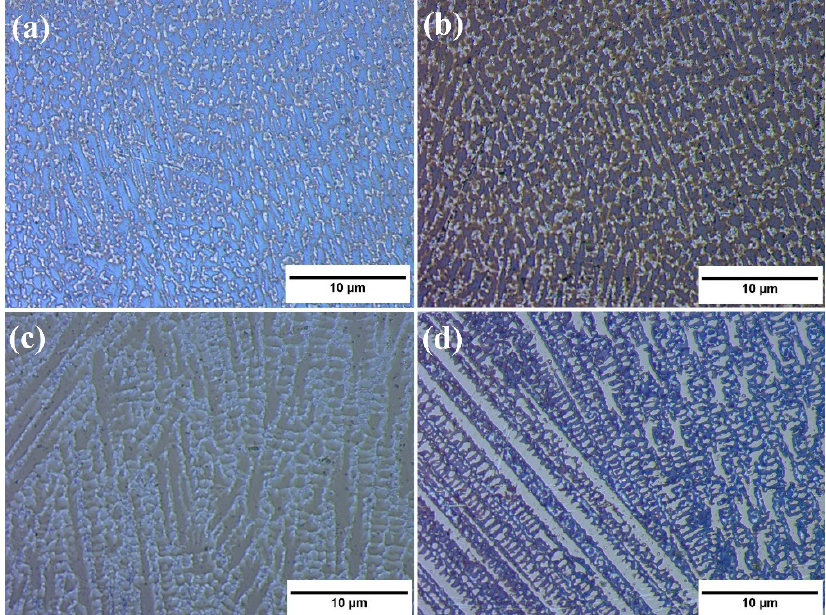
Figure 2. Microstructure of deposited coatings, electrochemical etched with oxalic acid, in cross section: ( a ) NiCr-coating without Ti addition; ( b ) with 3% Ti addition; ( c ) 5% Ti addition and ( d ) 10% Ti addition.